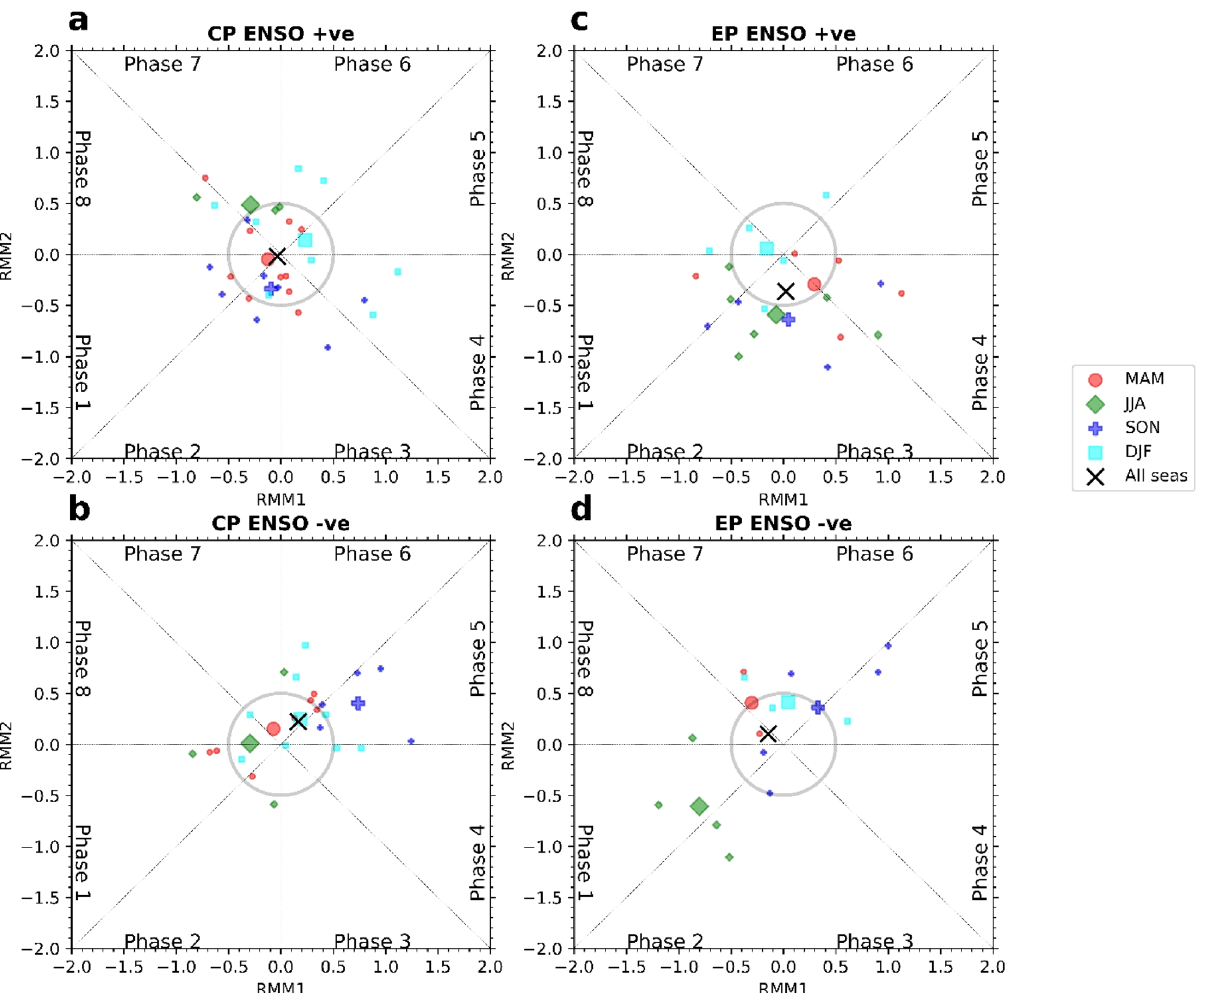
Figure 7. The mean location of MJO in WH04 RMM1-RMM2 plane during EP and CP-type ENSO seasons (MAM : red, JJA: green, SON: blue and DJF: cyan). ( a , c ) Represent the mean MJO location during positive and negative CP-type ENSO phases. Similarly, ( b , d ) represent the mean MJO location during positive and negative EP-type ENSO phases. The mean MJO location has been calculated from the mean of RMM1 and RMM2 value RMM 2 2 > 1.0 (MJO active during DJF (cyan), MAM (red), JJA (green), and SON (blue) when √ RMM 1 2 + condition). The black cross mark represents the mean position of MJO considering all the